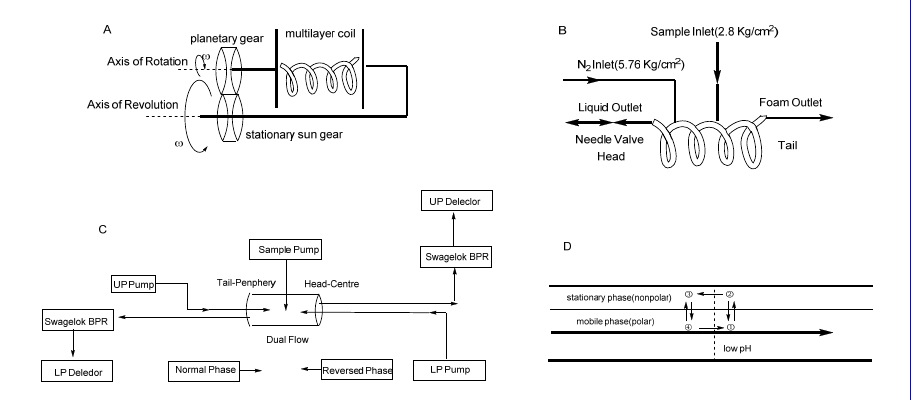
Figure 4. Schematic diagram of different types of HSCCC [47]. ( A ) The synchronous planetary motion of a multilayer coil separation column; ( B ) design of the coiled column for dual HSCCC; ( C ) Design of the coiled column for foam HSCCC; ( D ) mechanism of pH-zone-refining HSCCC.